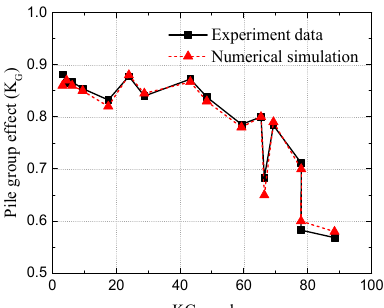
Figure 5. Variations of the pile group effect K G versus different KC numbers for the tandem arrangement with S G / D = 1.